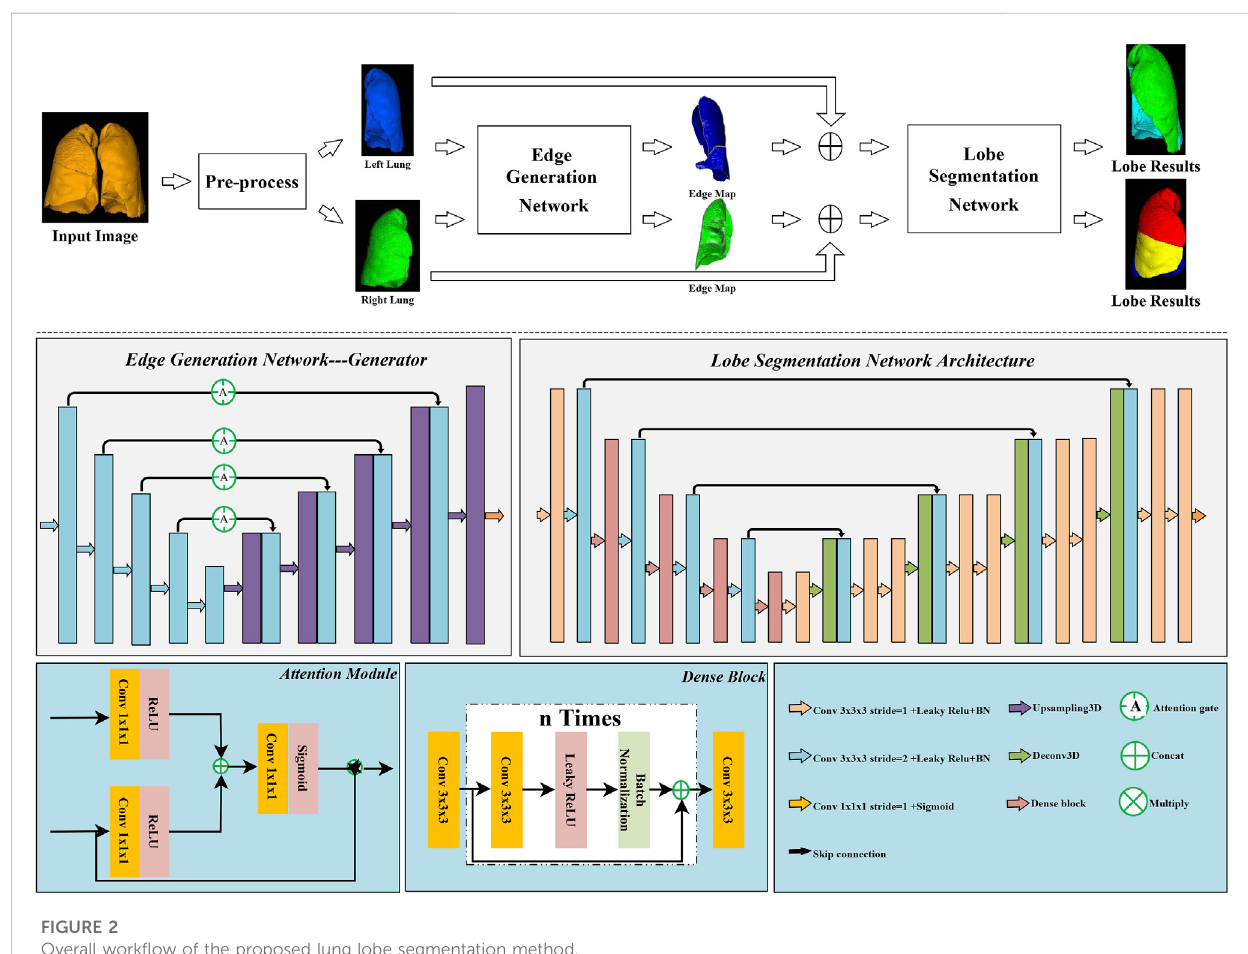
FIGURE 2 Overall work fl ow of the proposed lung lobe segmentation